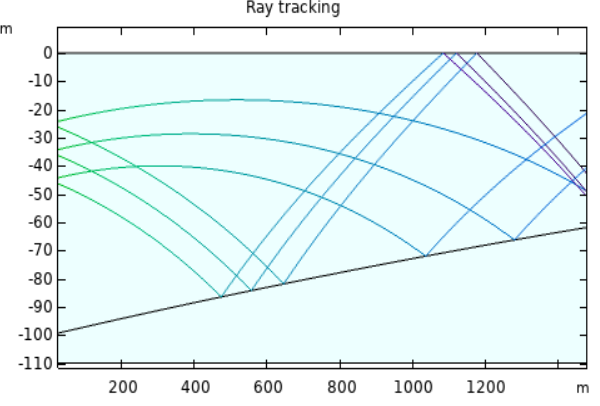
Figure 7. Ray trajectories at t = 1.0 s.